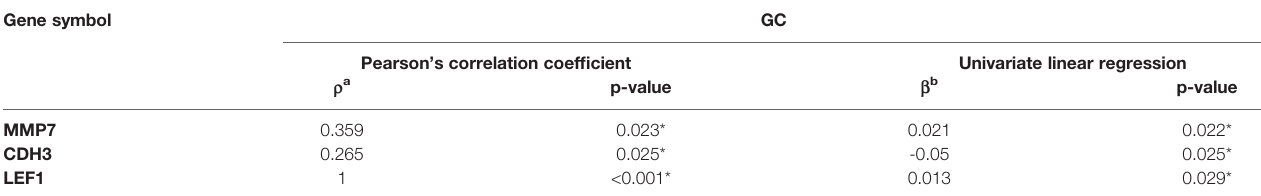
TABLE 4 | The correlation and linear regression analysis between GC and relevant gene